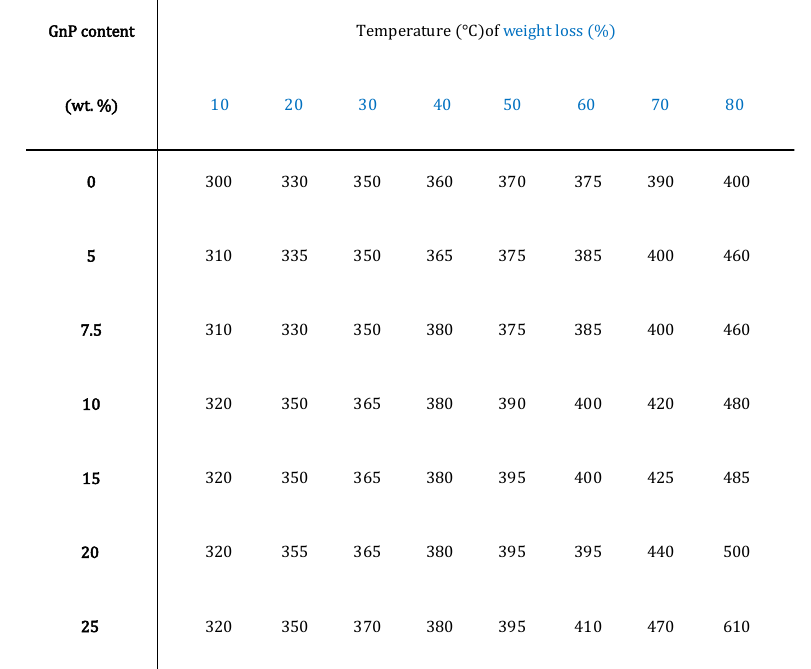
Figure 6. Decomposition temperatures of polyester nanocomposites.